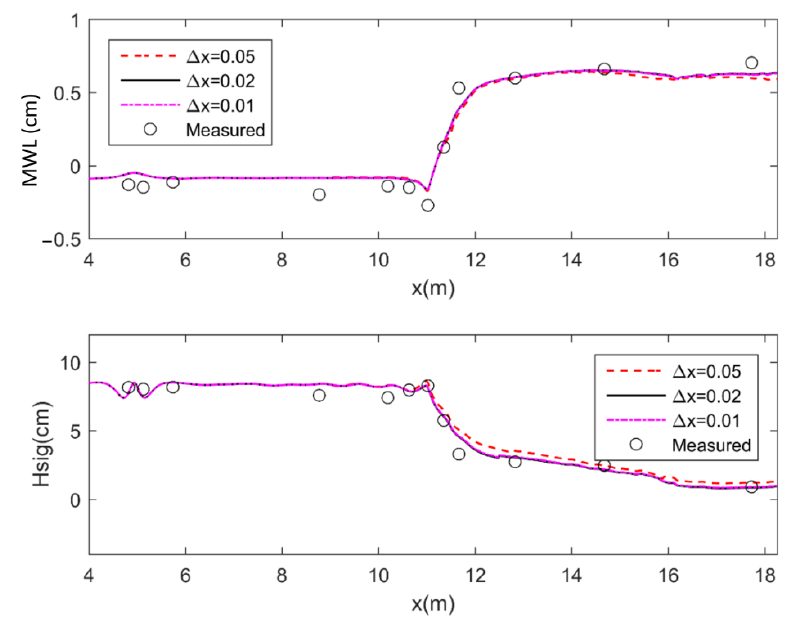
Figure 6. Comparison of simulation results with different nested grid sizes.